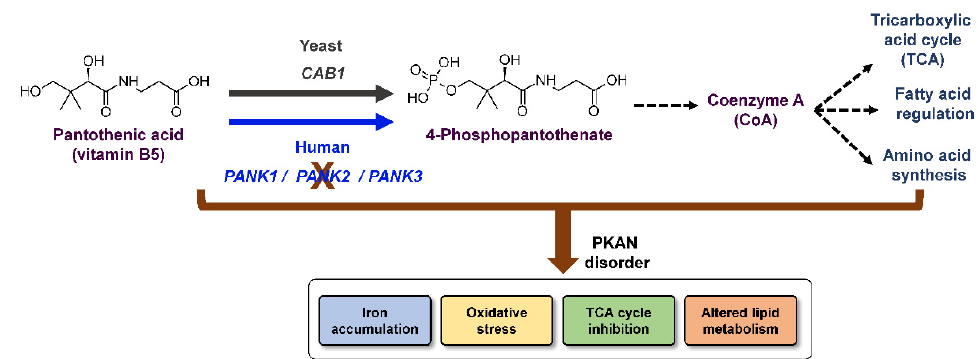
Figure 1. Pathway for CoA biosynthesis in humans and yeast and metabolic processes controlled by CoA. PanK enzymes catalyze the phosphorylation of pantothenic acid to form 4’- phosphopantothenate, which serves as a precursor for the biosynthesis of CoA. In yeast, PanK activity is catalyzed by the Cab1 enzyme, which is encoded by the CAB1 gene. In humans, 4 PanK isoforms encoded by three PANK genes ( PANK1 , 2 and 3 ) catalyze pantothenate phosphorylation. Mutations in the PANK2 gene lead to major cellular and metabolic alterations, which ultimately result in the manifestations of the clinical symptoms of PKAN.